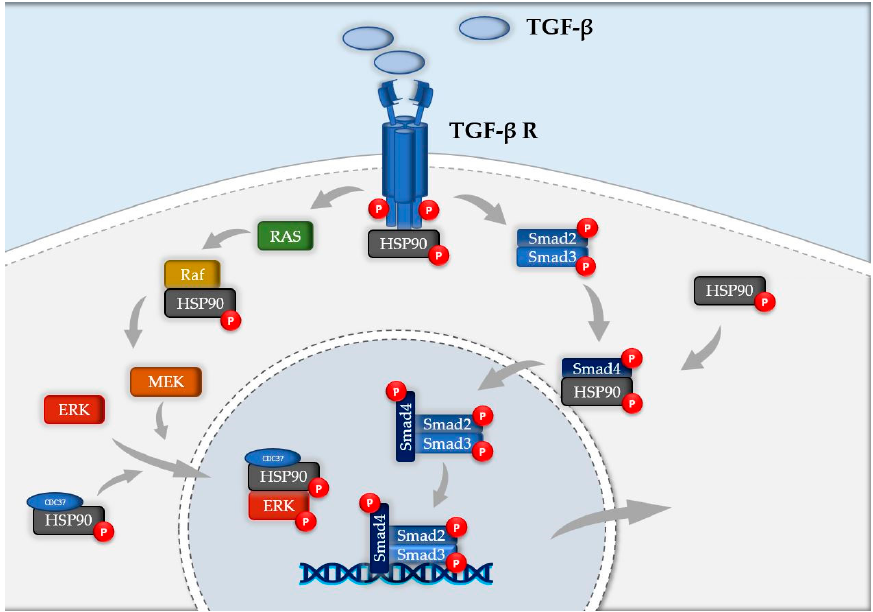
Figure 4. Schematic representation of HSP90 involvement in TGF- β signaling cascade. HSP90 plays a crucial role at various levels of the pathogenic pathway of IPF. It stabilizes TGF- β receptor, negatively regulates Raf, preserve ERK from degradation with its binding with HSP90-CDC37 complex and modulates nuclear localization of phospho-Smad4.